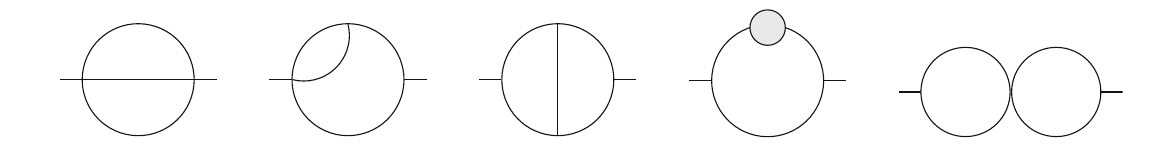
Fig. 1 Topologies of 2-loop contributions to the 2-point functions of the elementary fields. The blob in the fourth diagram represents an insertion of a 1-loop self-energy